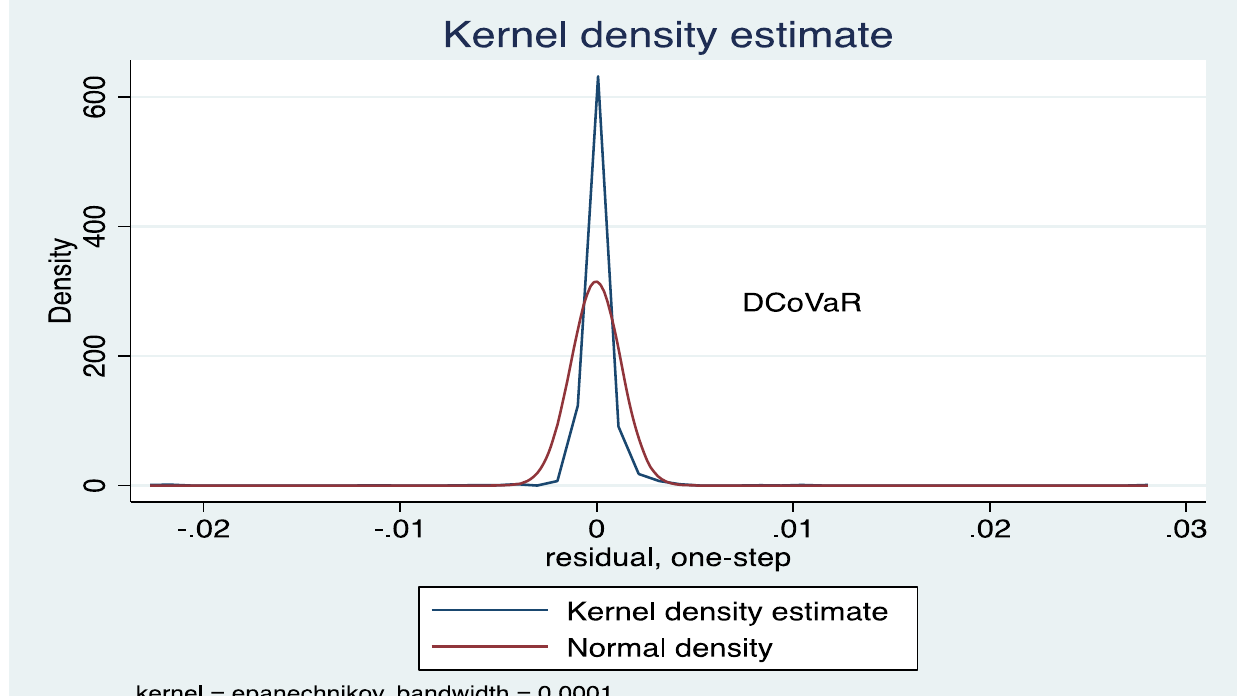
Figure A1. Residual distribution curve. 2. ARIMA (1,0,1) Δ CoVaR Using ARIMA (1,0,1) both AR(1) and MA(1) statistically significant and hint there are linear correlation or autocorrelation .